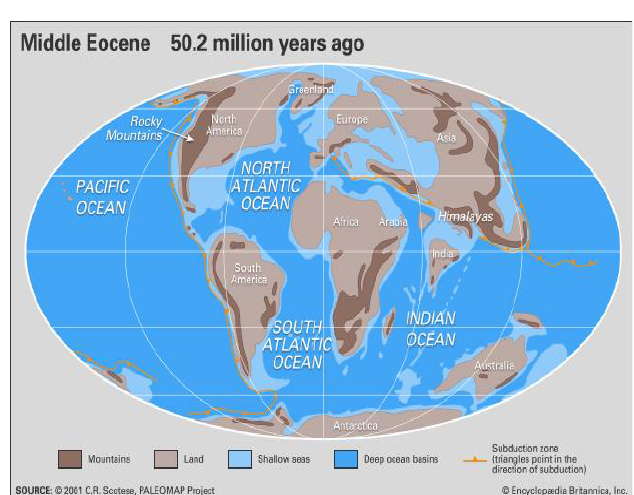
Figure 1: The paleogeographic map showing the distribution of the oceans in the Middle Eocene